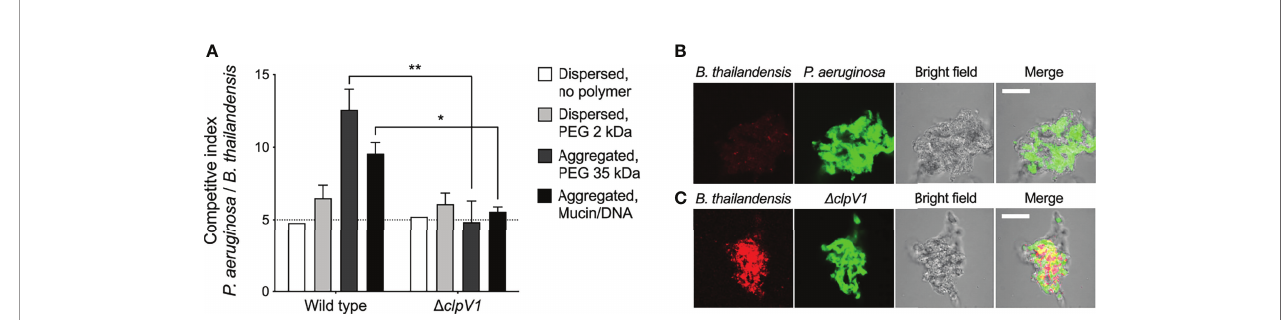
FIGURE 6 | Depletion aggregation promotes contact-dependent bacterial competition. (A) The outcome of competitions between B. thailandensis and either wild-type or D clpV1 P. aeruginosa are shown. Initial cultures contained 1x10 8 CFU/ml P. aeruginosa and 2x10 7 CFU/ml B. thailandensis. Results are after 24-h of co-culture in the indicated conditions and are the mean ± SD, N = 3 for each condition; **p < 0.01, Student ’ s t -test. (B, C) Confocal microscopy was used to visualize depletion aggregates after 24-h of co-culture with 30% PEG 35 kDa. Representative 10µm thick sections through the aggregates are shown with (B) . thailandensis strains in red and P. aeruginosa in green. Scale bar, 30 µm. *P <